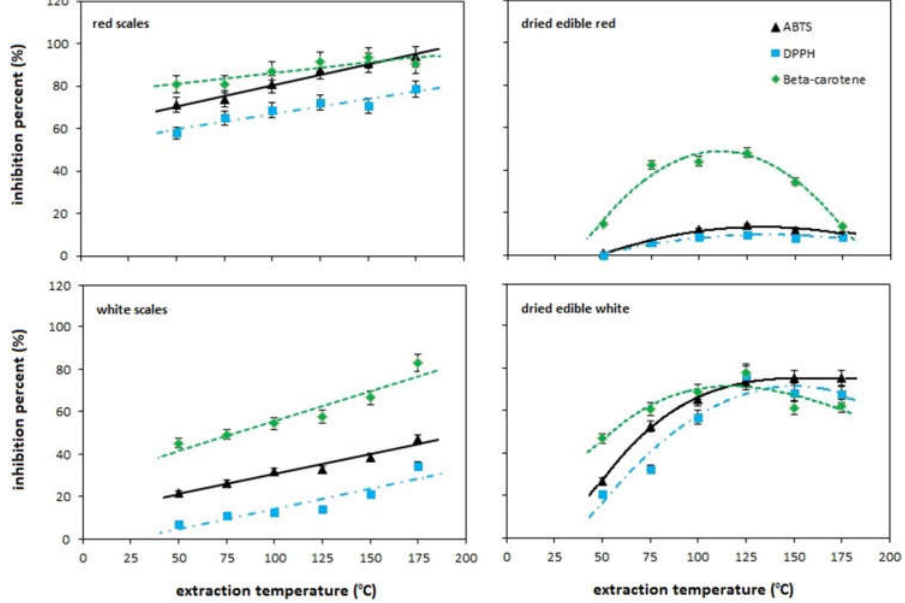
Figure 3. Effect of PHWE temperature on the antioxidant activities of white and red onion extracts determined using ABTS (black solid line with triangles), DPPH (blue dashed line with squares) and β-carotene bleaching assays (green dashed line with diamonds).